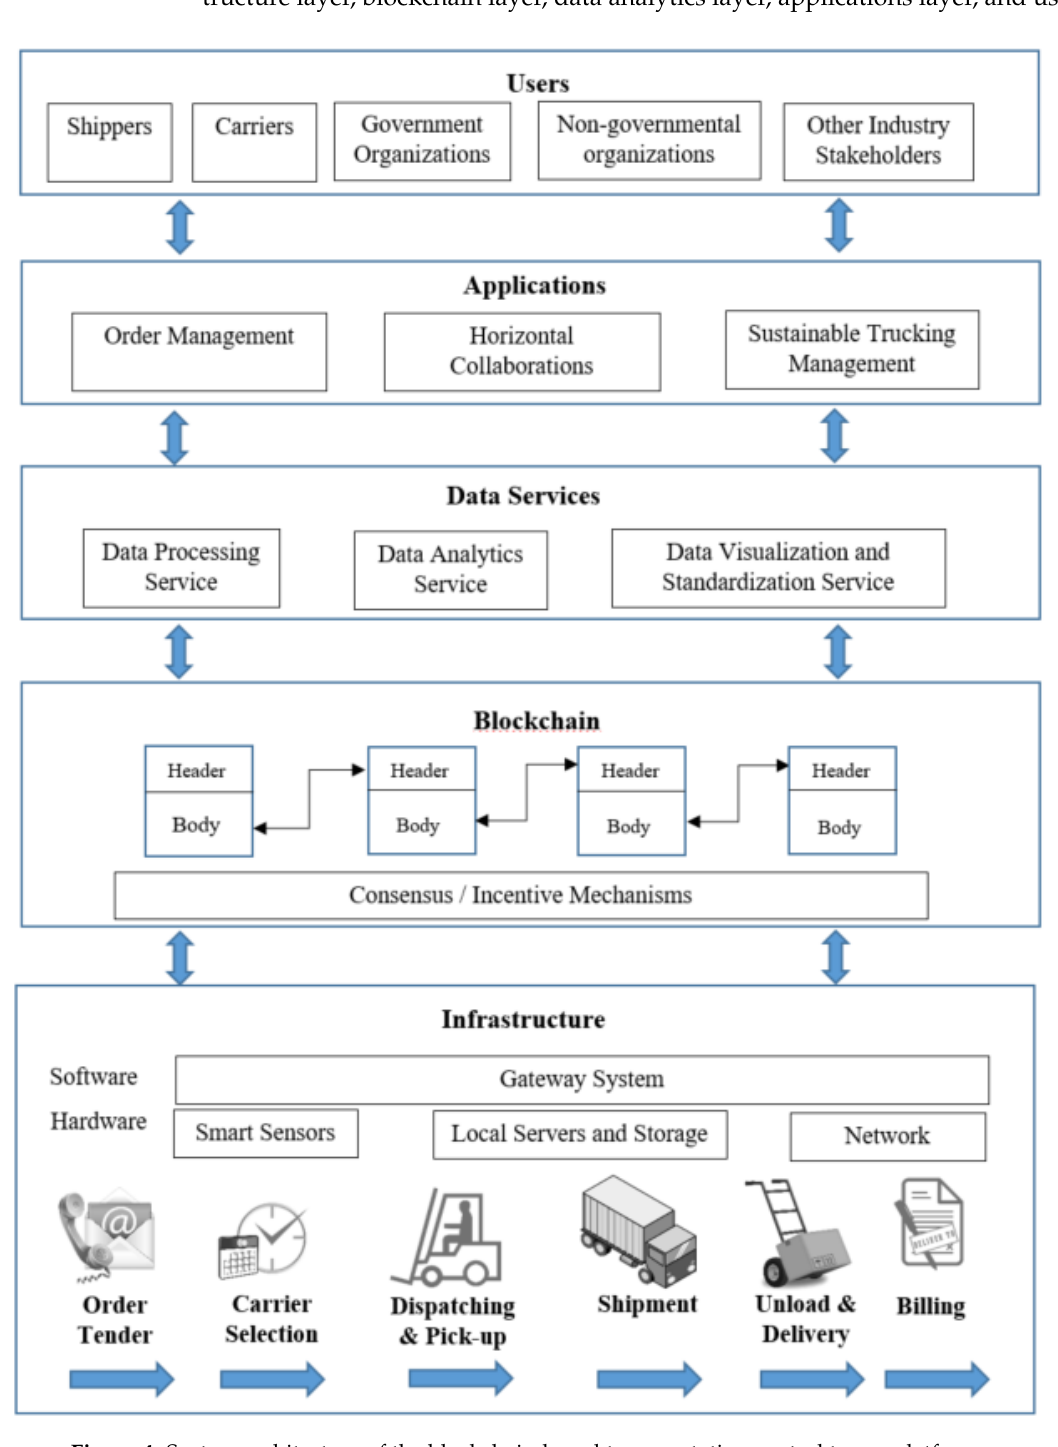
Figure 4. System architecture of the blockchain-based transportation control tower platform.